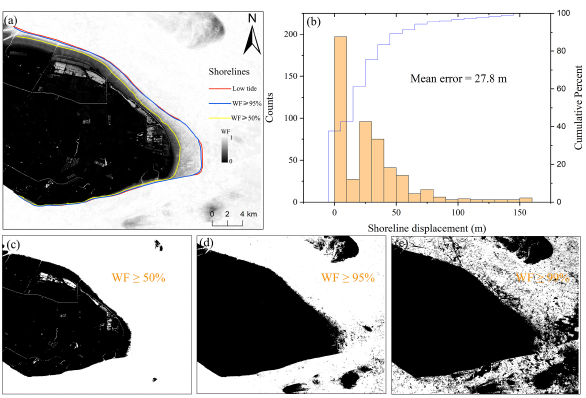
Figure 5. Morphology of eastern Chongming Island under different threshold values of water frequency (WF).